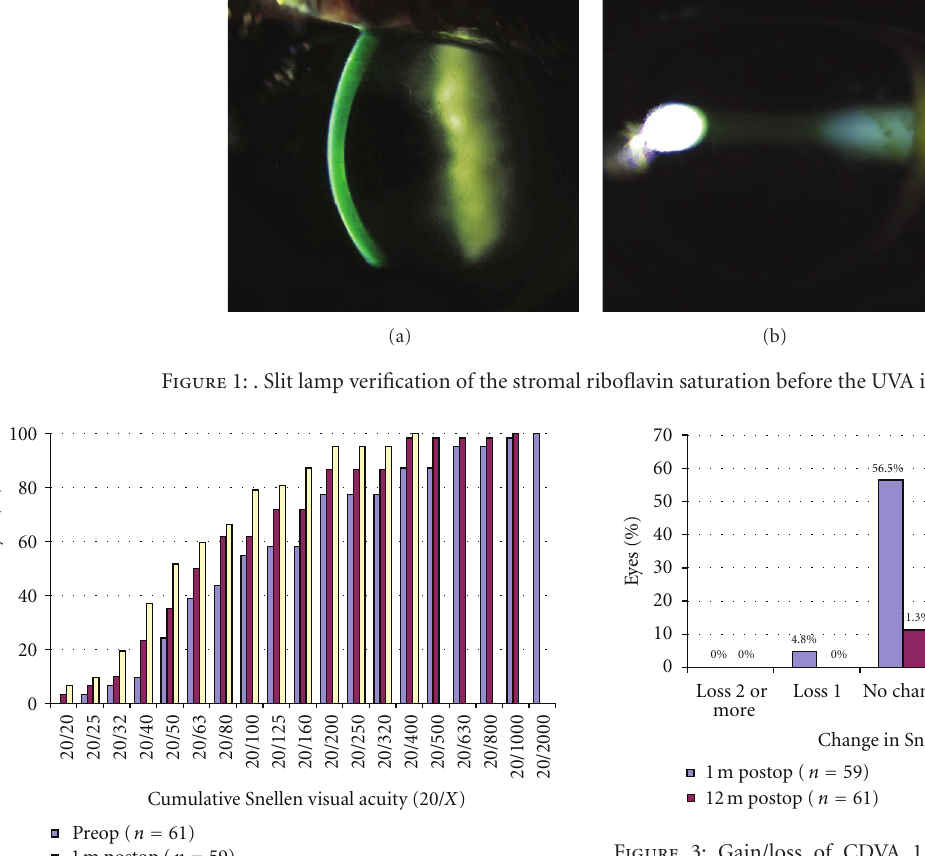
Figure 3: Gain/loss of CDVA 1 months and 12 months after epithelium-on